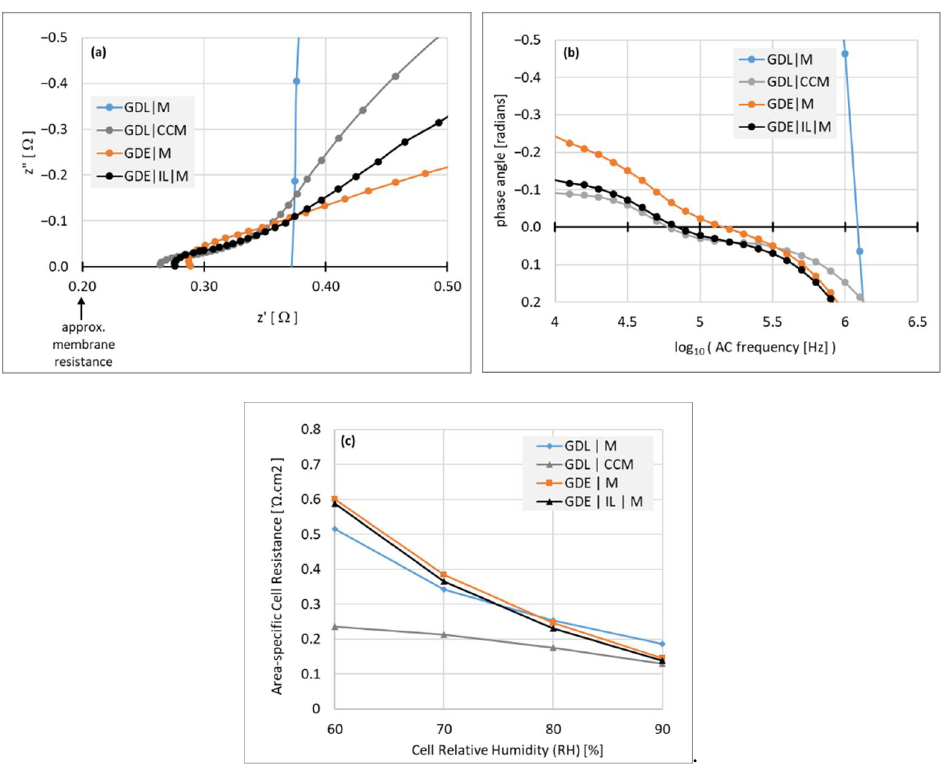
Figure 3. Interfacial resistance data from through-plane measurements of impedance of different MEA construction methods, taken at T = 80 ℃ in bicarbonate form. ( a ) Nyquist plots, z” vs z’, taken at 90% RH; ( b ) the same data set, plotting phase angle of the alternating current (AC) against AC frequency; ( c ) area-specific resistance isotherms at varying RH from 60 to 90%.